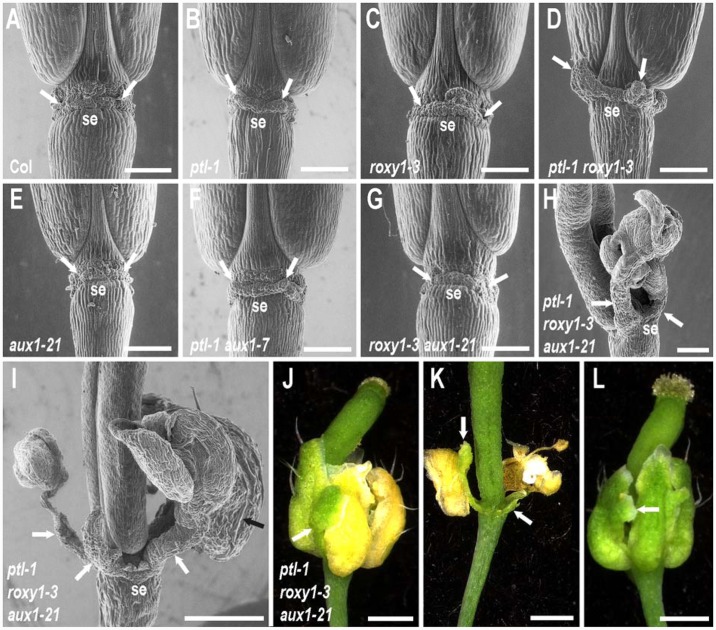
Role of PTL and ROXY1 in limiting growth within the first whorl.
(A–I) SEMs of the base of mature stage 17 siliques of wild type and combinations of ptl-1. roxy1-3, and aux1 mutations in lateral view, with the site of abscission of one sepal labeled below (se) and the two adjacent inter-sepal zones indicated by white arrows. Some outgrowth of the inter-sepal zone occurred in ptl-1 single mutant siliques (arrows in B) compared with the same region in wild type controls (arrows in A). This was enhanced in ptl-1 roxy1-3 double mutants (D), but did not occur in roxy1-3 single mutants (C). Addition of aux1 mutation had no effect alone (E) or in combination with roxy1-3
(G), and did not result in further outgrowth with ptl-1
(F). However, greatly enhanced outgrowth often occurred in ptl-1 roxy1-3 aux1-21 triple mutants where clusters of ectopic organs on stalks may arise (white arrows in H, I). These were sepal-like, with characteristic long cells on their abaxial surface (black arrow in I). (J–L) Light micrographs of flowers of a ptl-1 roxy1-3 aux1-21 triple mutant plants. Outgrowths of inter-sepal zone tissues (arrows in J, K) senesced later than sepals and remained green after the normal sepals had turned yellow (J) and later abscised (K). Ectopic growths on the margins of the normally placed sepals was often observed, including additional sepal-like tissue (L, arrow). All plants were grown together and are from the same experiment shown in Figure 2. Bars represent 250 μm (A–H) or 500 μm (I–L).